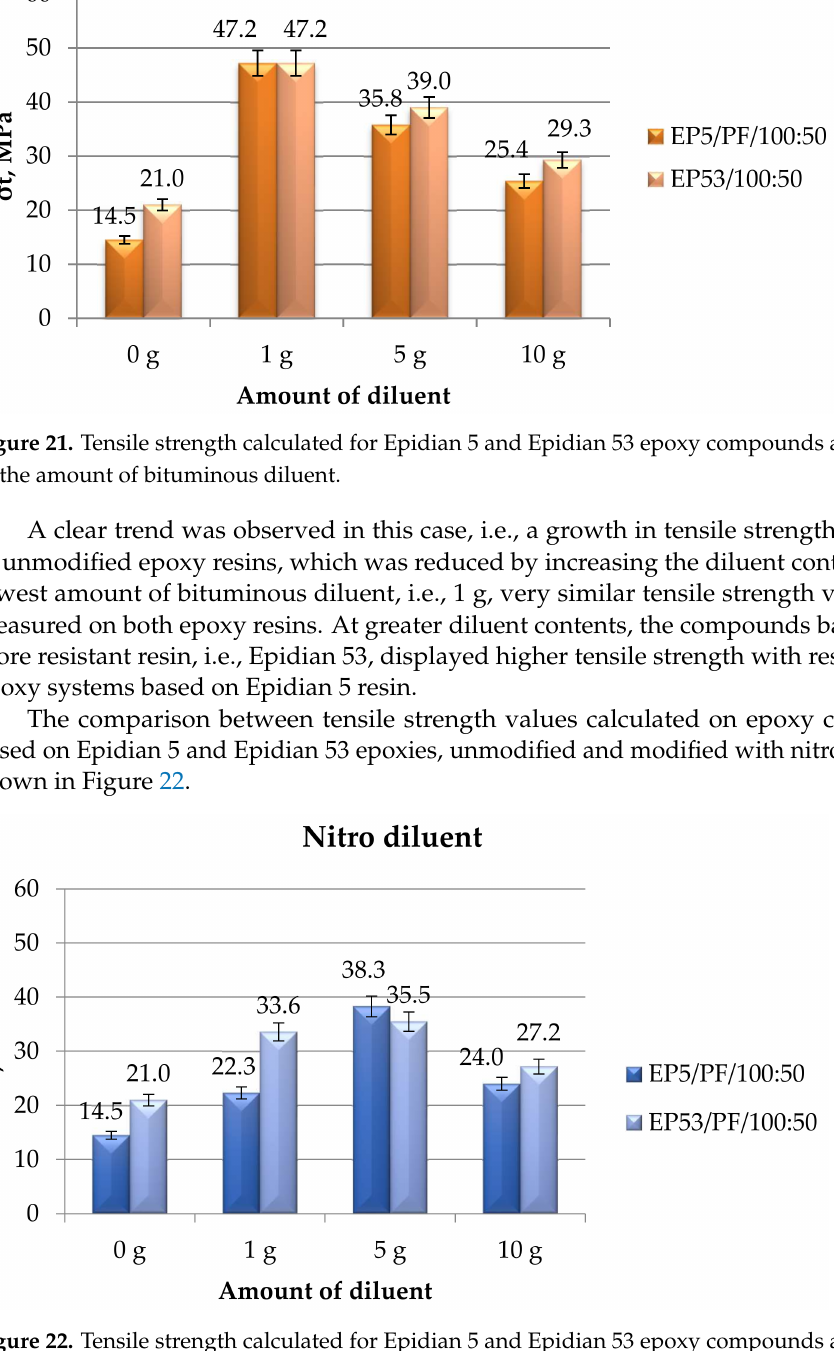
Figure 22. Tensile strength calculated for Epidian 5 and Epidian 53 epoxy compounds as a function of the amount of nitro